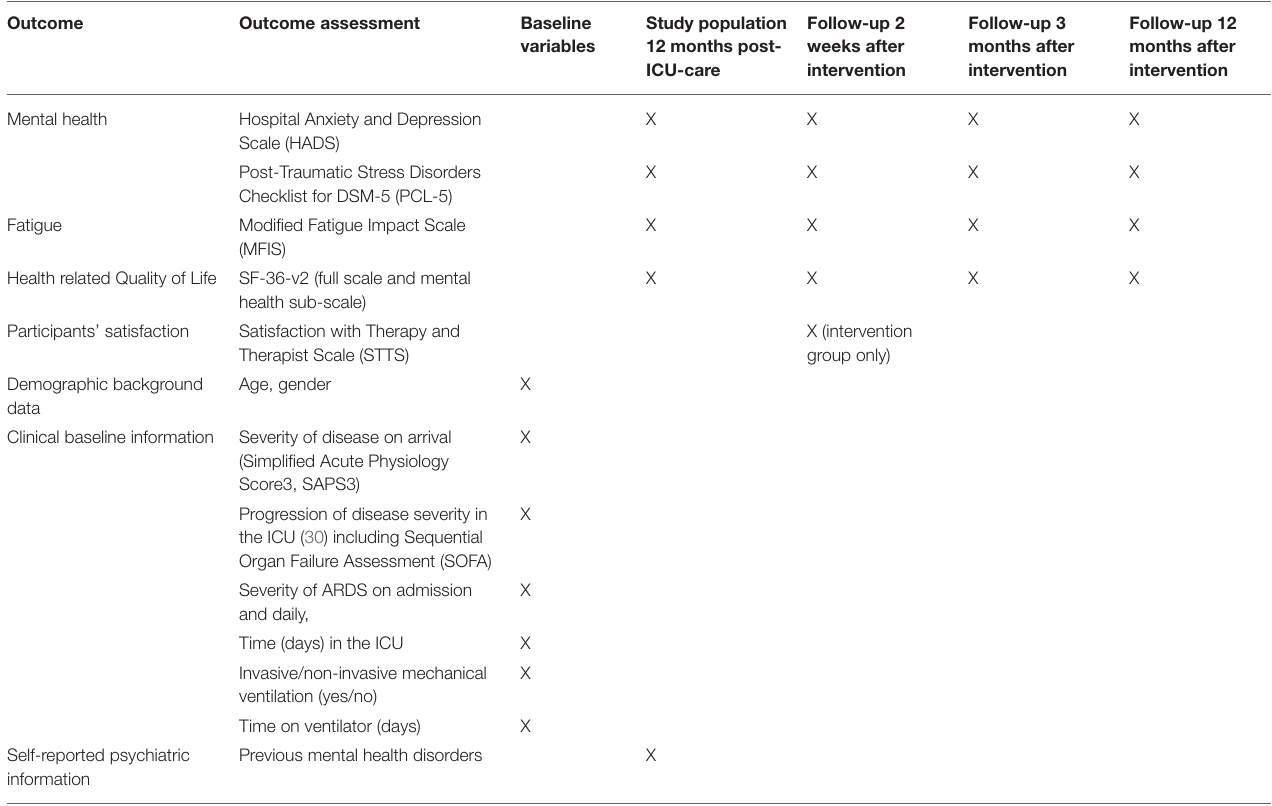
TABLE 1 | Outcome assessments at baseline and follow-up.